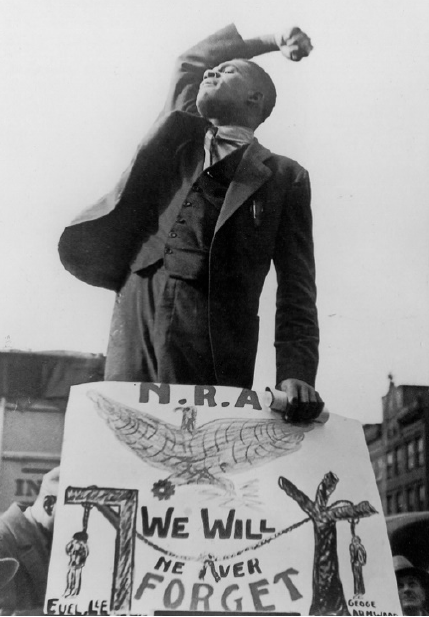
Figure 1. Leo Seltzer, ‘Speaker at Demonstration in Harlem, New York City’, 1933, gelatin silver print. © Leo Seltzer.